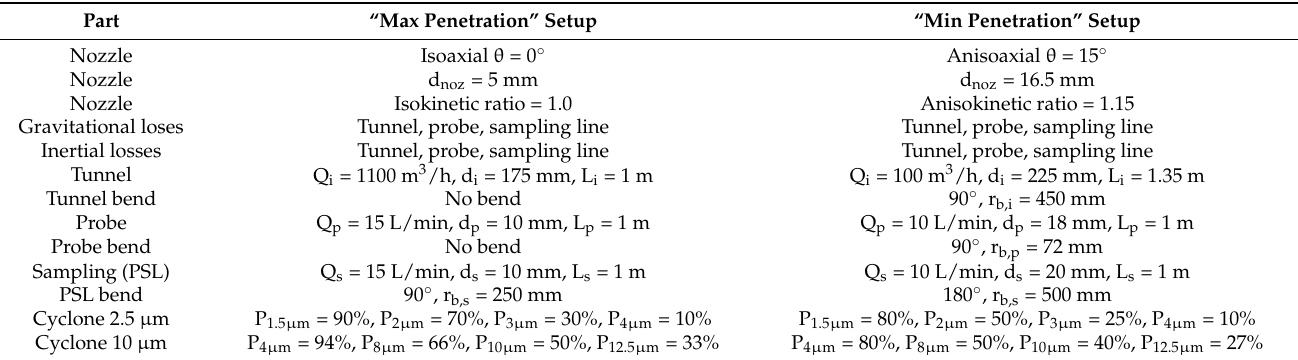
Table 1. Assumed parameters for the estimation of particle losses for the two